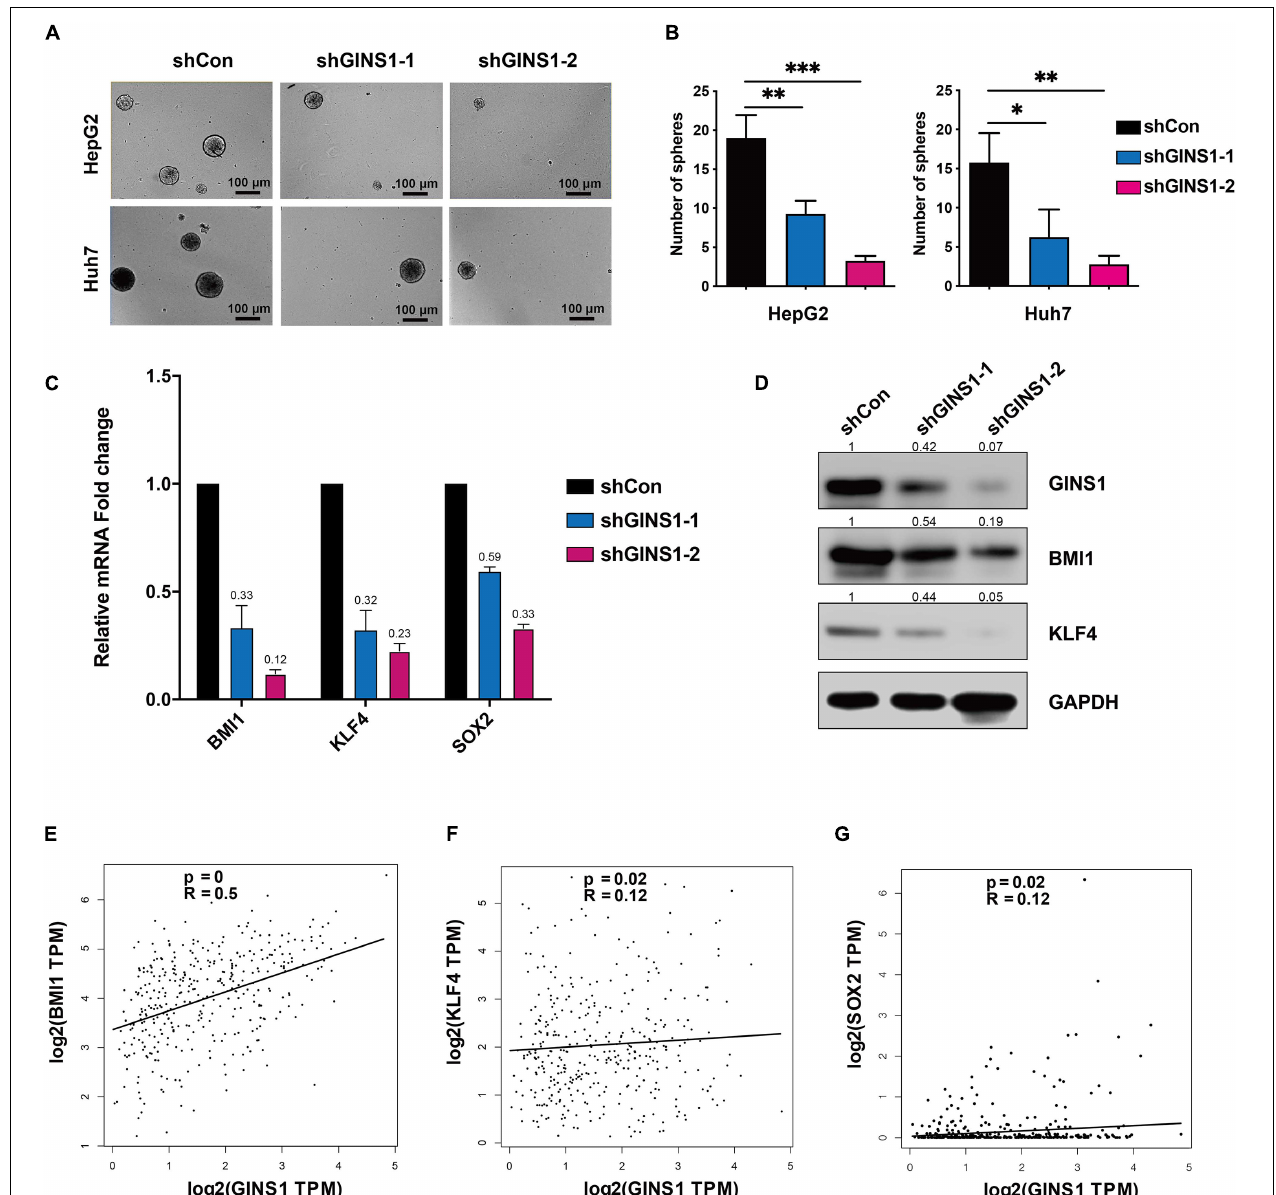
FIGURE 3 | CSCs regulated by GINS1 in HCC cells. (A,B) images of the sphere of HepG2 and Huh7 cells w/o GINS1 ablation were captured (A) and the number of sphere formation was quantified (B ; mean ± SD). Scale bar represents 100 µ m. (C) transcription levels of CSCs markers in Huh7 shCon or shGINS1 cells were determined by RT-qPCR. (D) protein expression of CSCs markers in shCon or shGINS1 cells were determined by immunoblot, and the expression ratio was counted. (E–G) correlation of CSCs markers [BMI1 (E) , KLF4 (F) , and SOX2 (G) ] and GINS1 expression present within TCGA database. Data are presented as mean ± SD. ∗ P < 0.05; ∗∗ P < 0.01; and ∗∗∗ P <